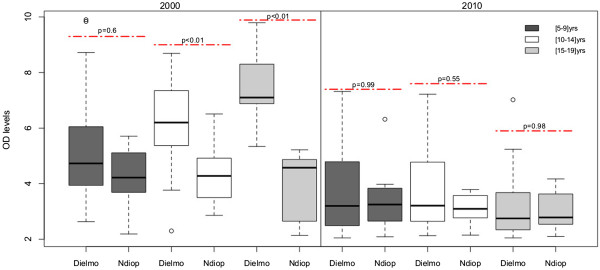
Antibody responses to crude extracts
Sch
07/03 according to age group: comparison of the responses between Dielmo and Ndiop in 2000 and 2010 in positive responders only.